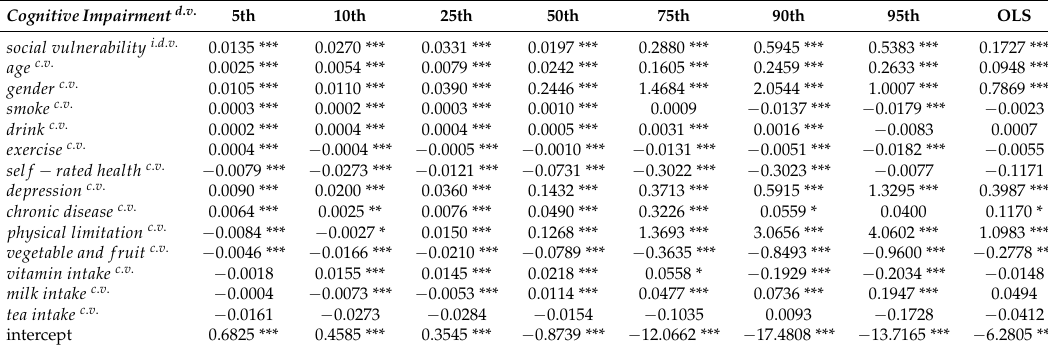
Table 3. Unconditional quantile regression and OLS results